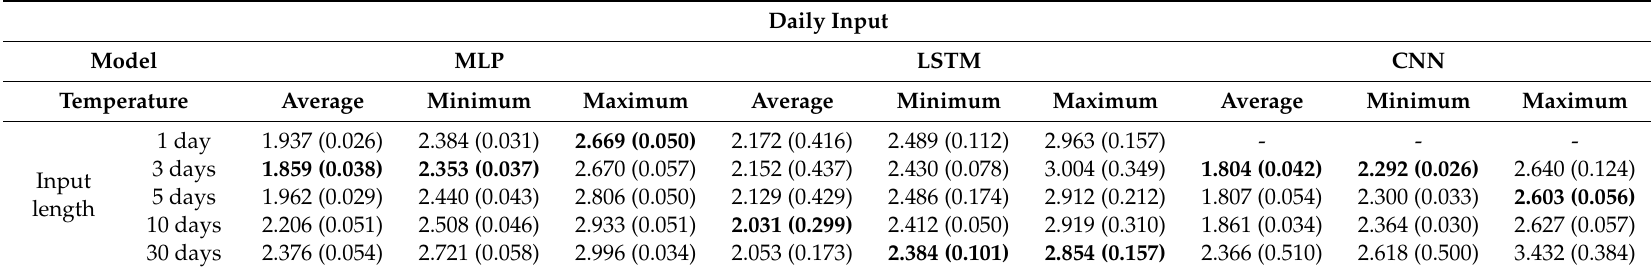
Table 16. Forecasting results, represented using the MAE, for mountainous area